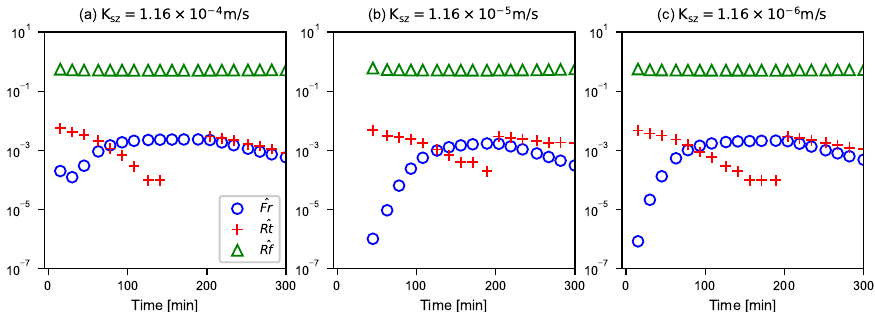
Figure 5. The numerical dimensionless numbers at ( x , z ) = ( 400,0 ) m for three test cases of rainfall on a sloping plane.